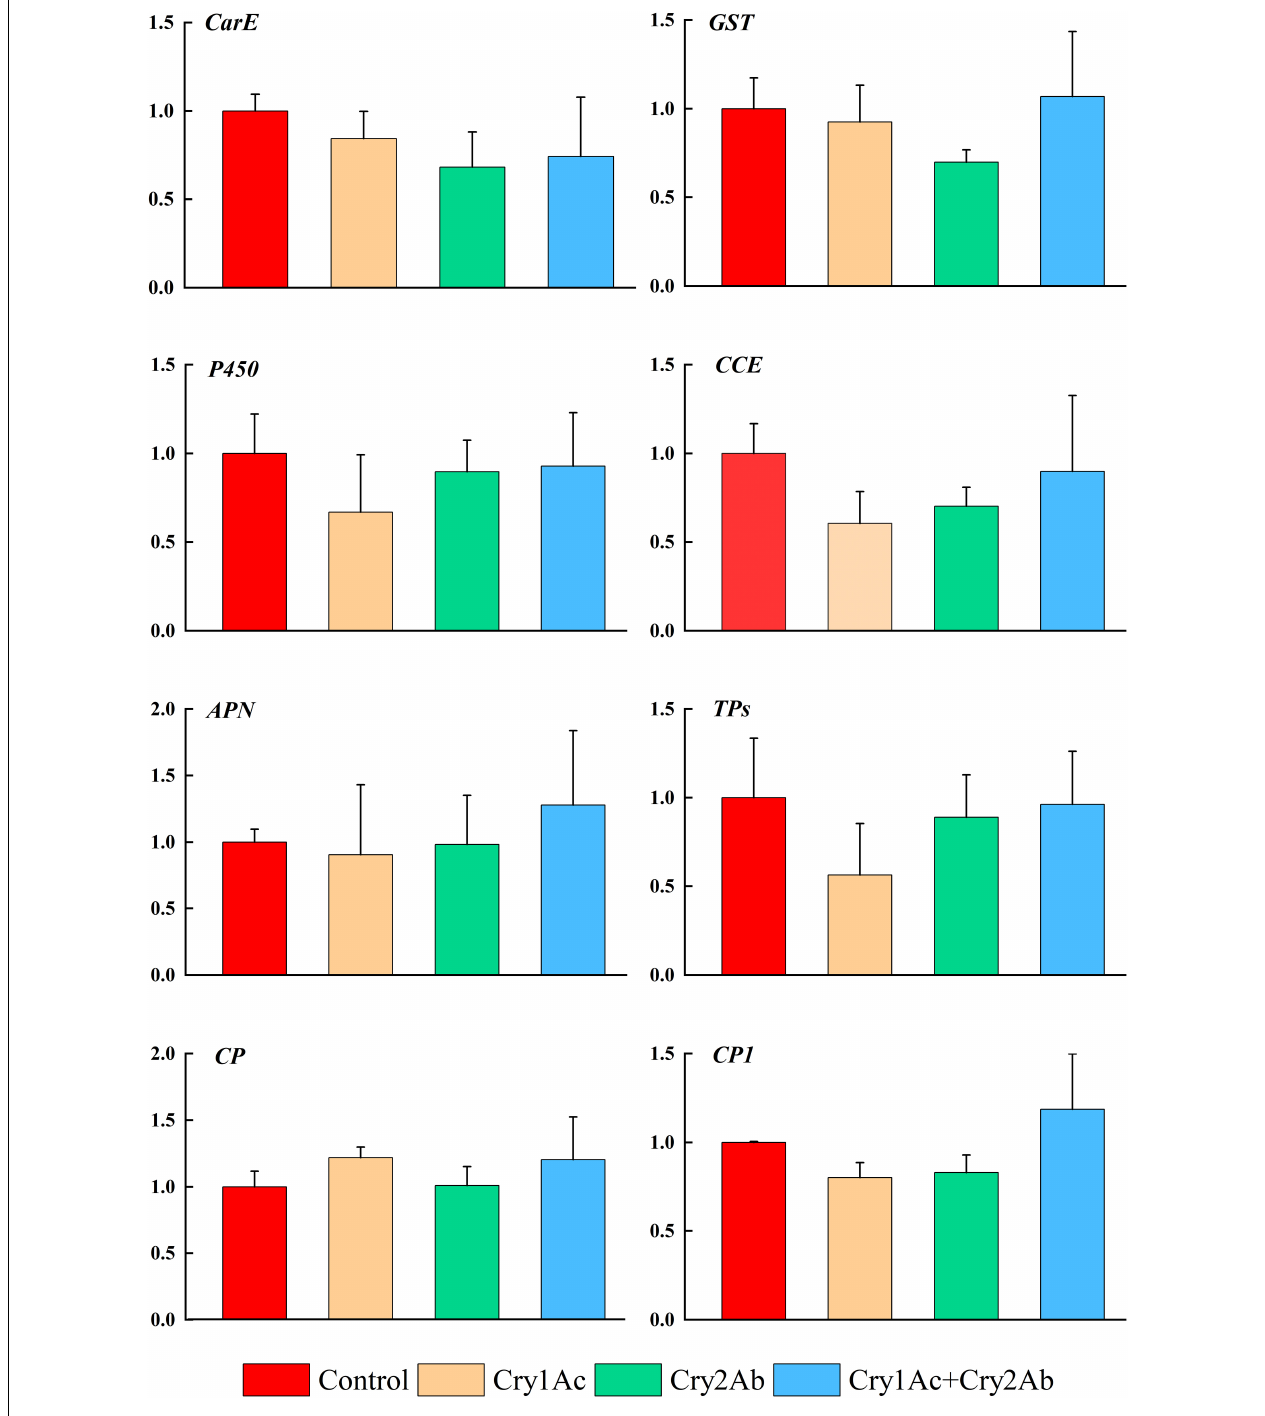
FIGURE 3 | Relative expression levels of detoxification and digestion related genes of P. japonica when fed artificial diets containing Cry1Ac or/and Cry2Ab. The data represents as the mean ± SE. One-way ANOVA was performed, followed by Tukey HSD comparison test, P < 0.05.